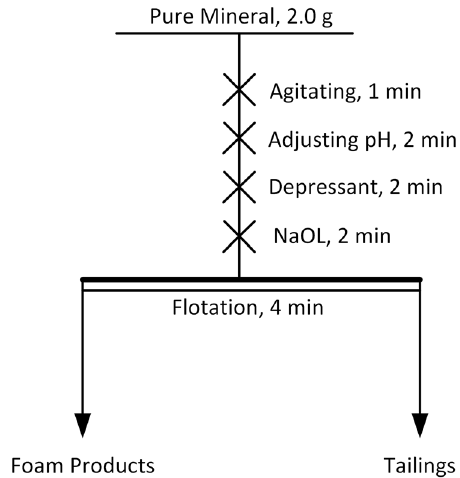
Figure 2. Flotation test flowsheet of pure minerals.